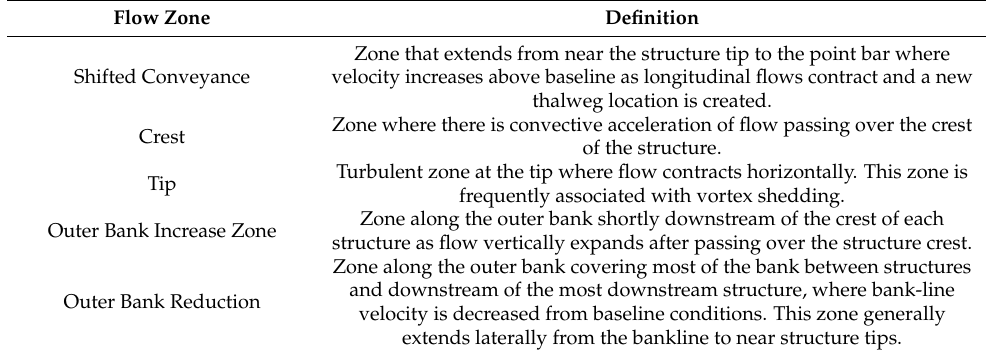
Table 7. Definition of Flow Zones from Rock Vanes and Bendway